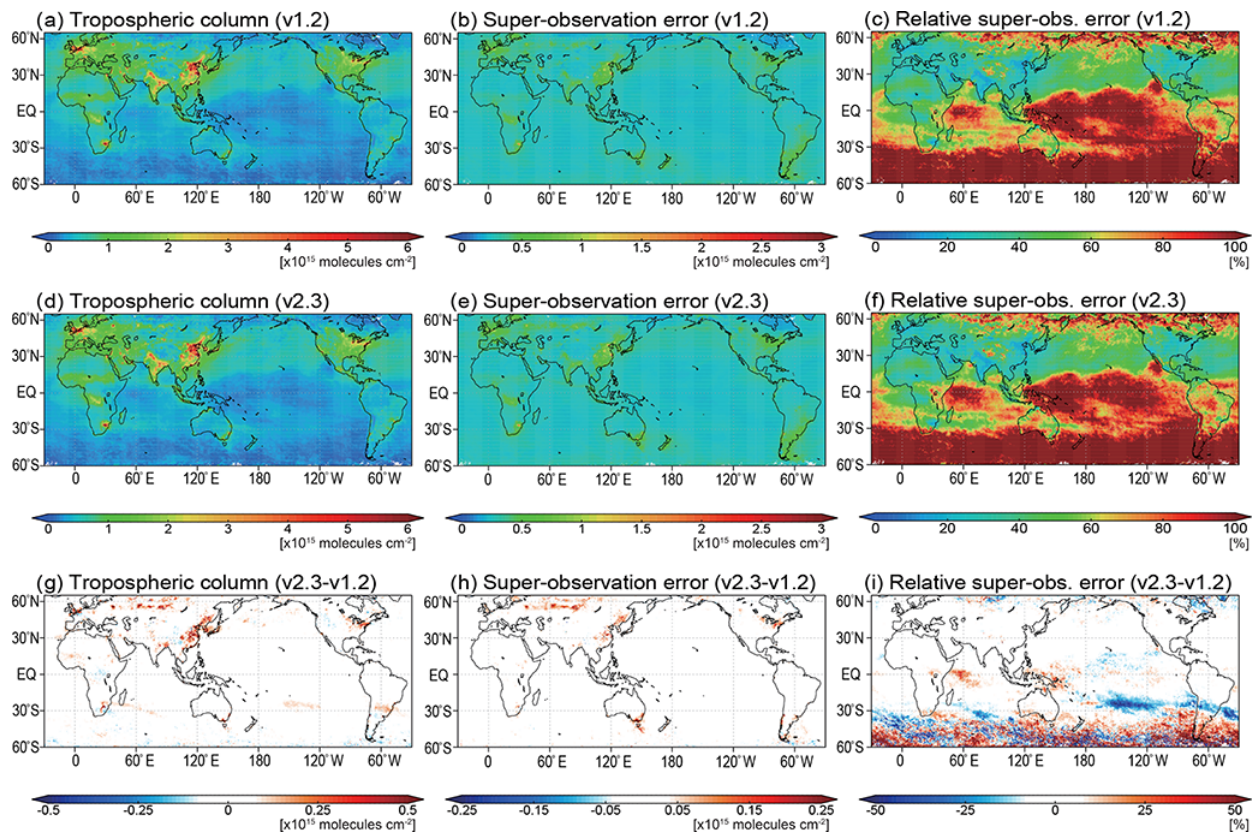
Figure B1. Global distribution of tropospheric NO 2 column (a, d, g) , super-observation errors (b, e, h) , and relative super-observation errors (c, f, i) obtained from the Tropospheric Monitoring Instrument (TROPOMI) version 1.2 beta product (a, b, c) and TROPOMI S5P-PAL (same as version 2.3.1) product (d, e, f) , as well as the differences between TROPOMI version 1.2 beta and S5P-PAL products (g, h, i) during May 2018. The units of the tropospheric NO 2 column, super-observation errors, and relative super-observation errors are × 10 15 molec.cm − 2 , × 10 15 molec.cm − 2 , and percentage (%),